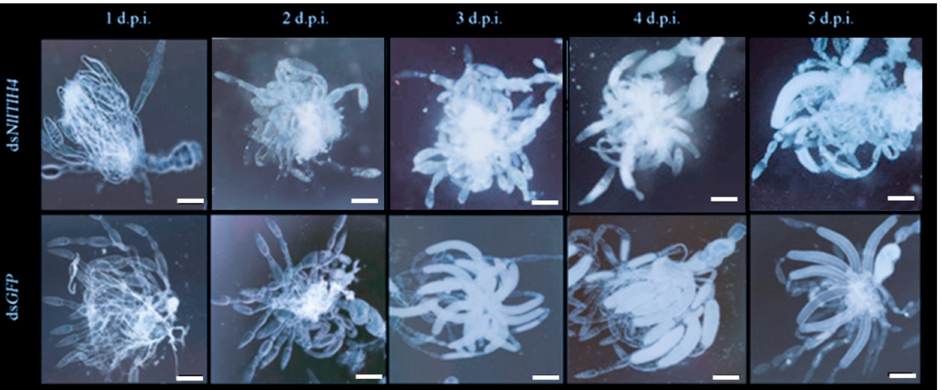
Figure 5. Effects of dsRNA injection on ovarian development at 1 to 5 days post injection of dsRNA (d.p.i.). At 1 to 2 d.p.i., there was no visible difference between the ovaries from ds NlITIH4 -treated and ds GFP -treated groups, but notable differences are present at 3 to 5 d.p.i. Scale bar: 400 µ